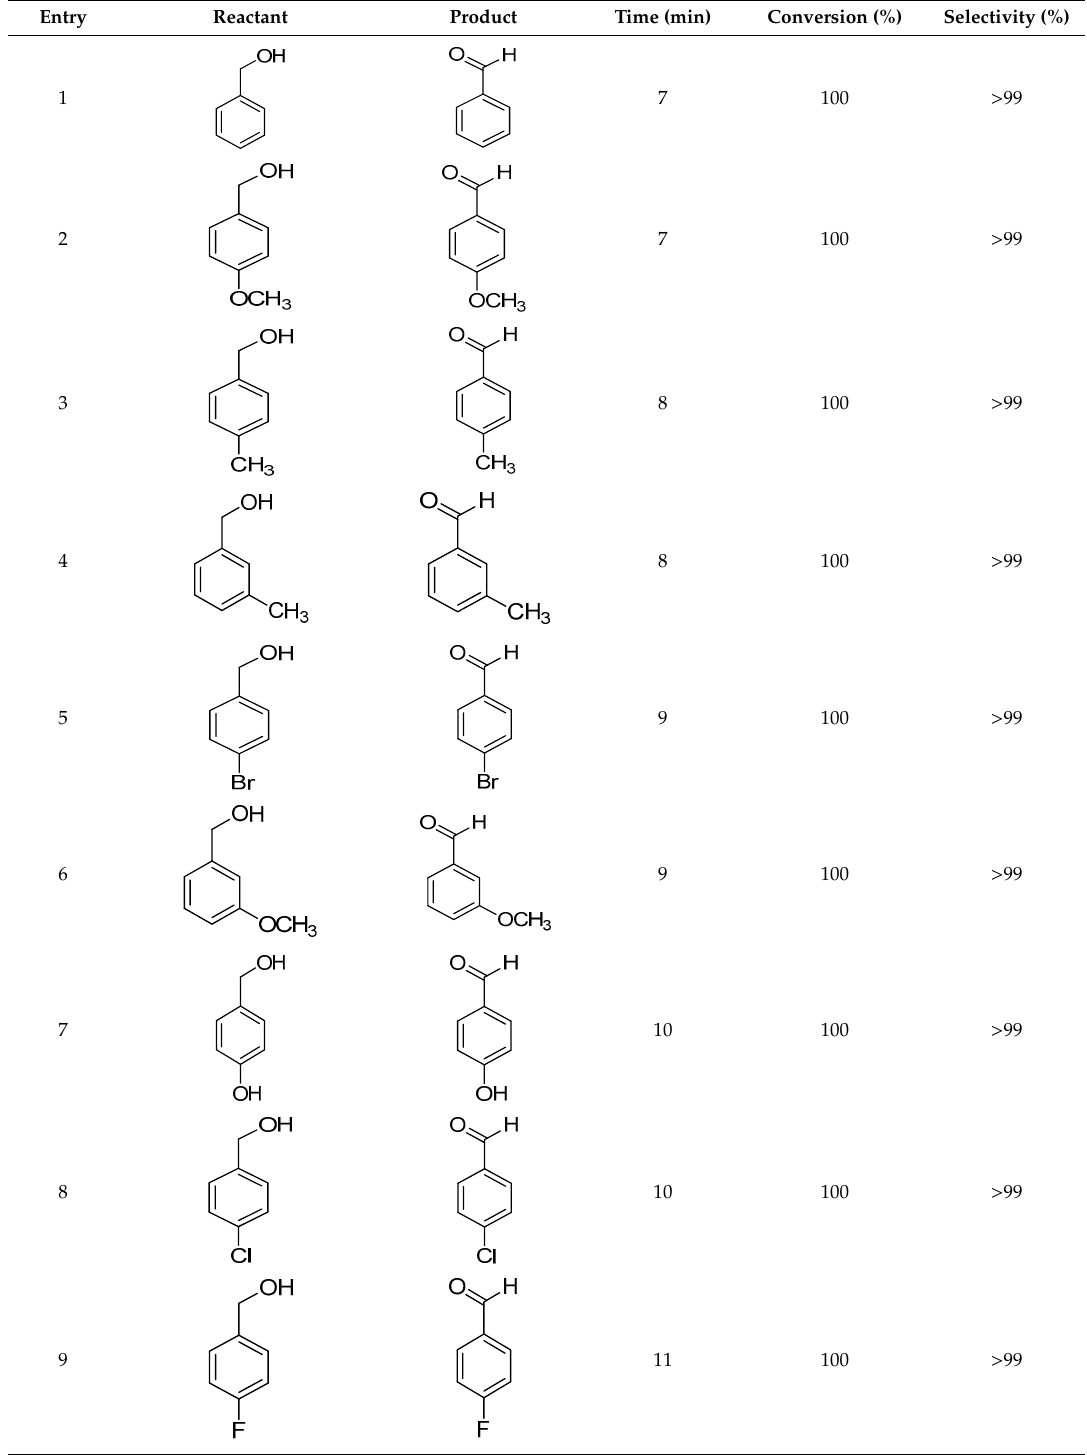
Table 4. Catalytic oxidation of various kinds alcohols over (1%)ZrO x –MnCO 3 /(1%)GRO.